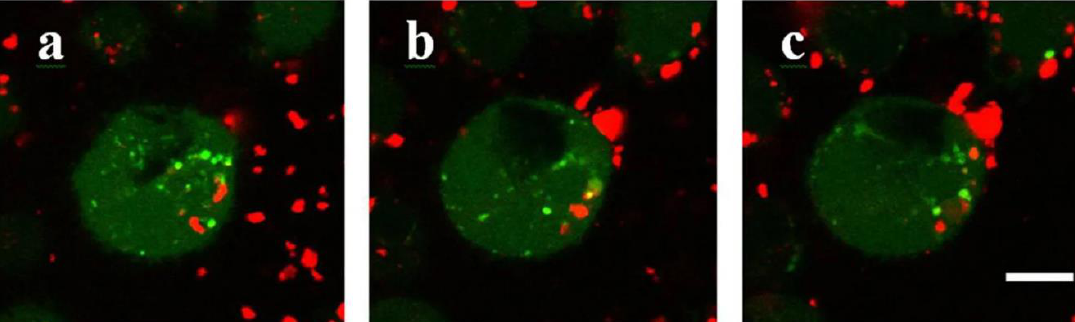
Figure 5. Observations by confocal microscopy to evaluate the interaction between J774 macrophase and CDs-coated MOFs, indicating that hybrid materials have penetrated into macrophase and affected its functions. Cells were stained in green with calcein, the cell nucleus is in black, and the rhodamine-B-labeled hybrid materials exhibited red signals. The differences of images ( a , b , c ) of the same cells caused by three different heights above the glass slide including 2.3, 4.9 and 7.6 µm, respectively. Scale bar = 5 µm. Reproduced from Reference [18] with permission from the Nature Publishing Group, copyright 2015.